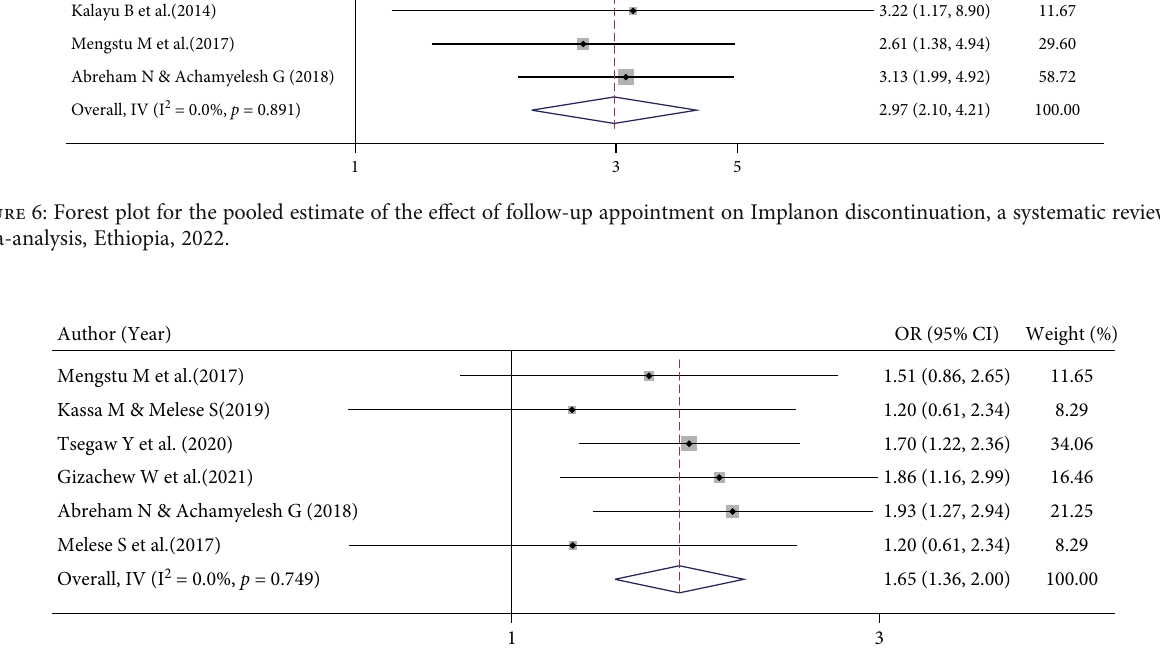
Figure 7: Forest plot for the pooled estimate of the e ff ect of counselling on Implanon discontinuation, a systematic review and meta- analysis, Ethiopia,